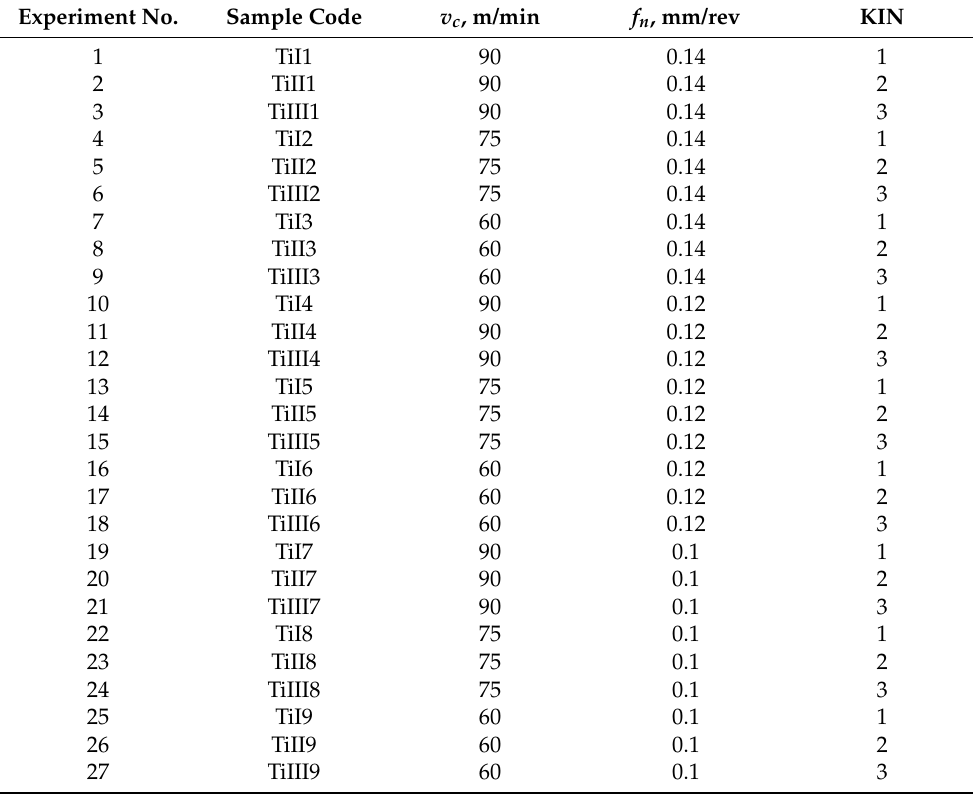
Table 4. Input parameters used in the drilling of 42CrMo4 + QT steel. Experiment